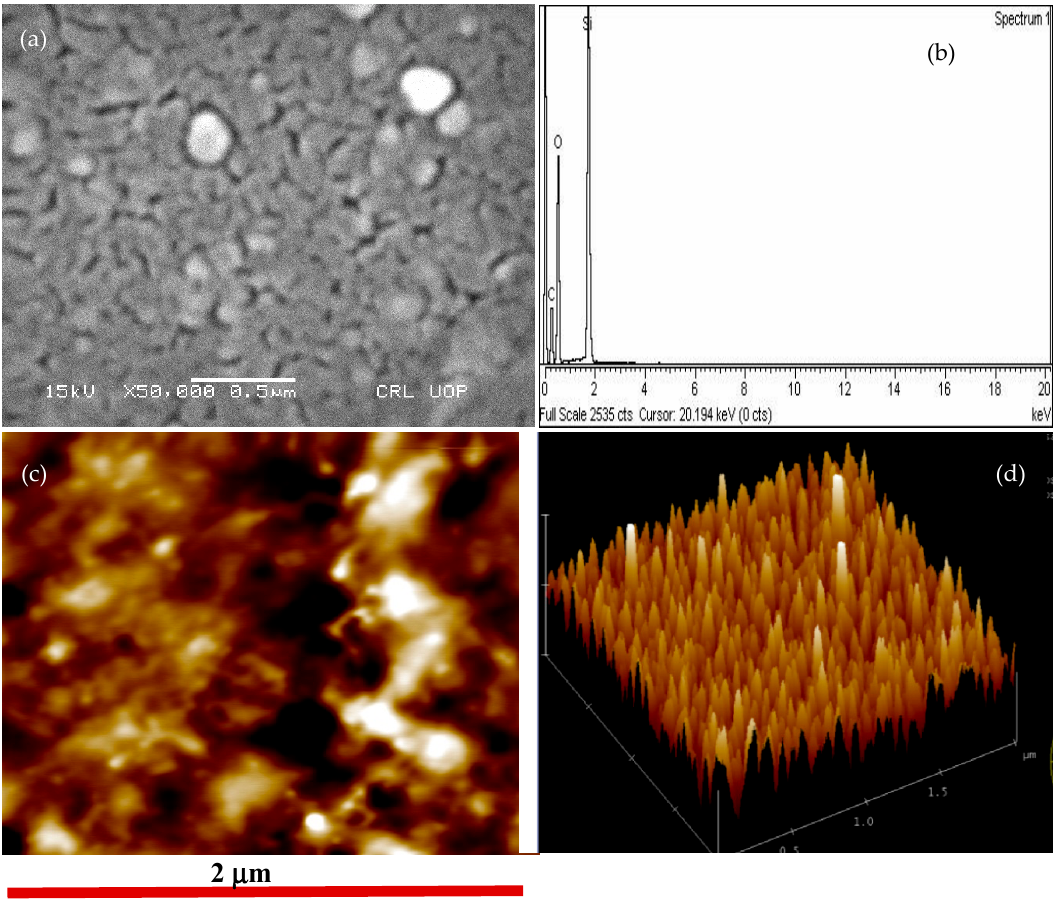
Figure 2. Surface morphology of PFB thin film: ( a ) SEM micrograph, ( b ) EDX spectrum, ( c ) 2D atomic force microscope (AFM) micrograph, and ( d ) 3D AFM image of PFB thin film.